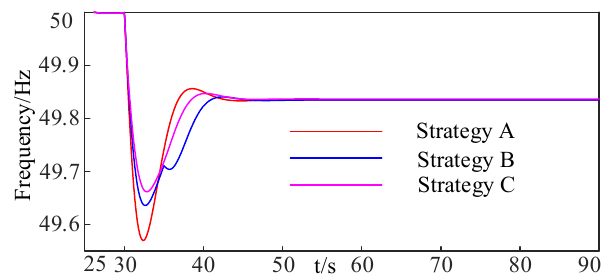
Figure 12. Variation of system frequency under different control strategies. Figure 12. variation of system frequency under different control strategies. Figure 12. variation of system frequency under different control strategies.